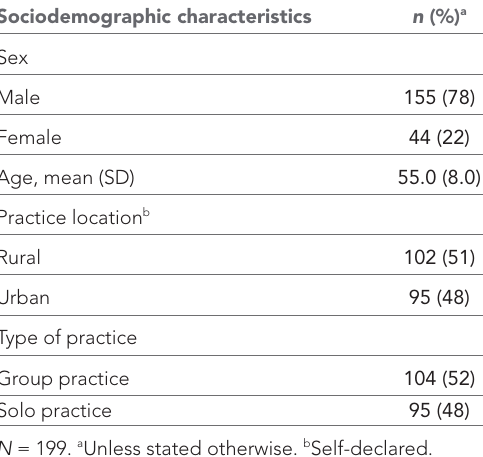
Table 2 Characteristics of the practices' organi- sation and GPs’ loss of meaning in